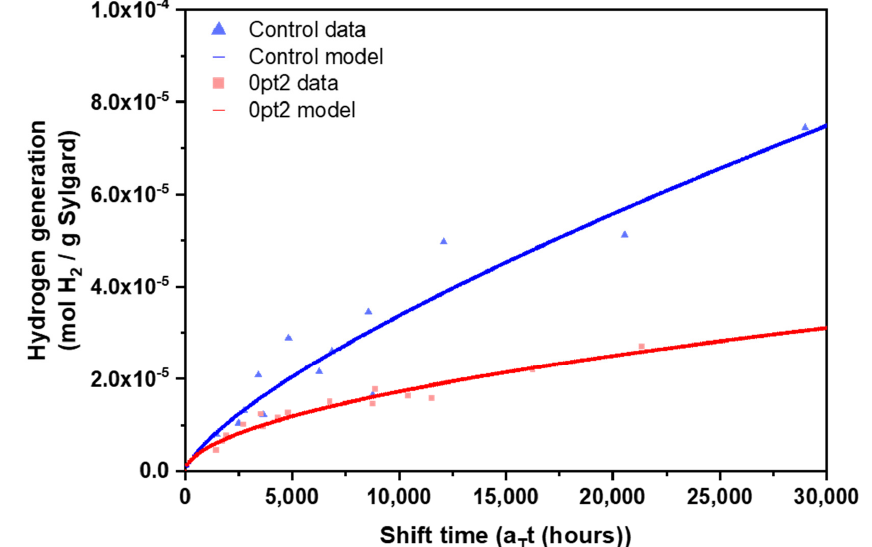
Figure A6. Hydrogen generation for the Control and 0pt2 formulations. Included is the shifted data and the model. For the Control, the equation is \ ( a T t ) = 4.22 × 10 − 8 a T t 0.7257 and for the 0p2, the equation is \ ( a T t ) = 1.20 × 10 − 7 a T t 0.5391 .